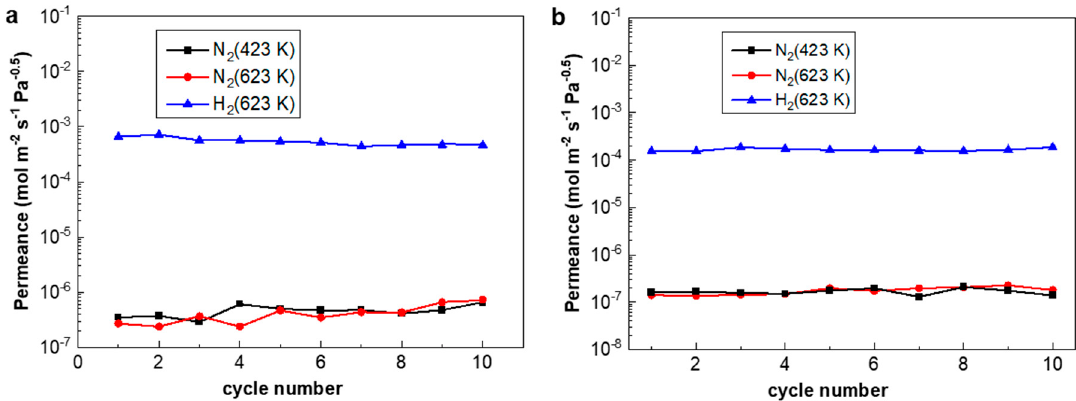
Figure 8. The performance of ( a ) PA-1 and ( b ) PA-2 during rapid heating/cooling cycles between 423 K and 623 K at a ramp rate of 10 K/min.